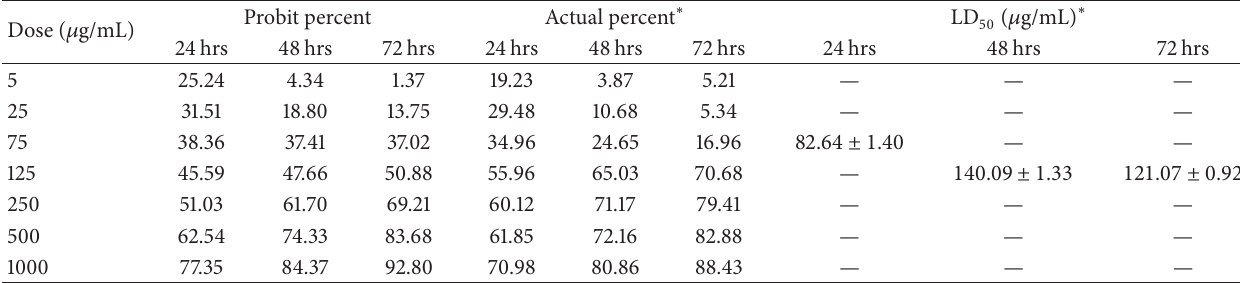
Table 4: Lethal dose at 50 percent reduction of the cell